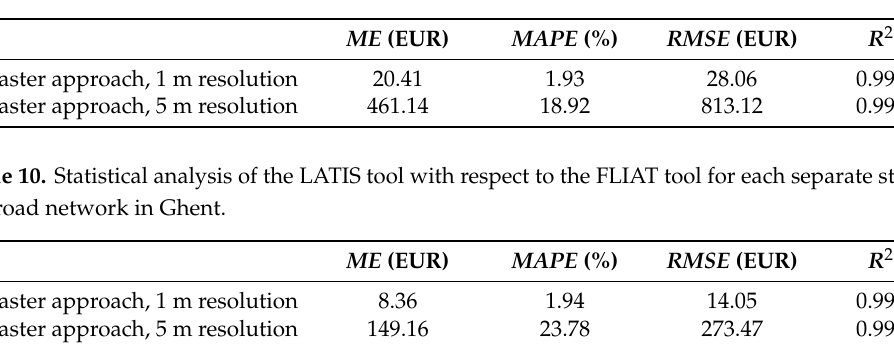
Table 9. Statistical analysis of the LATIS tool with respect to the FLIAT tool for each separate category of road network in Ghent.